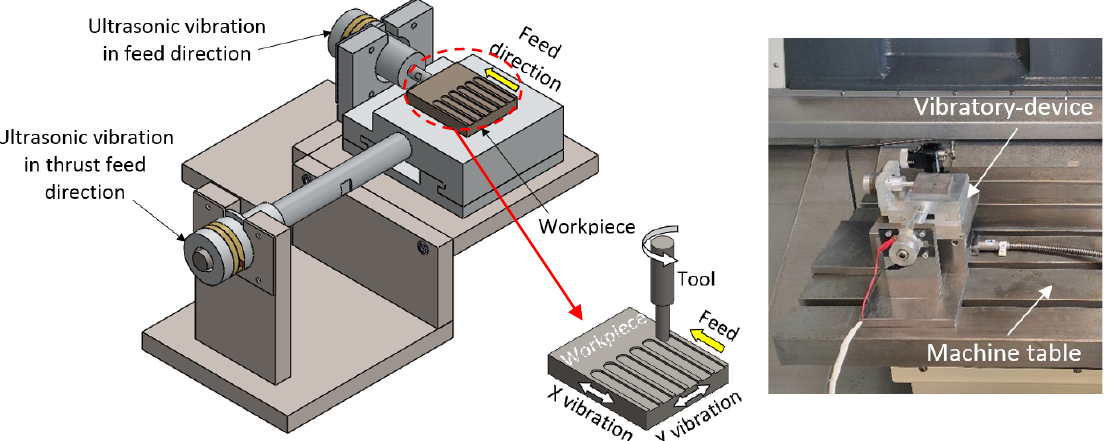
Figure 17. Experimental setup using the 2D vibratory device.